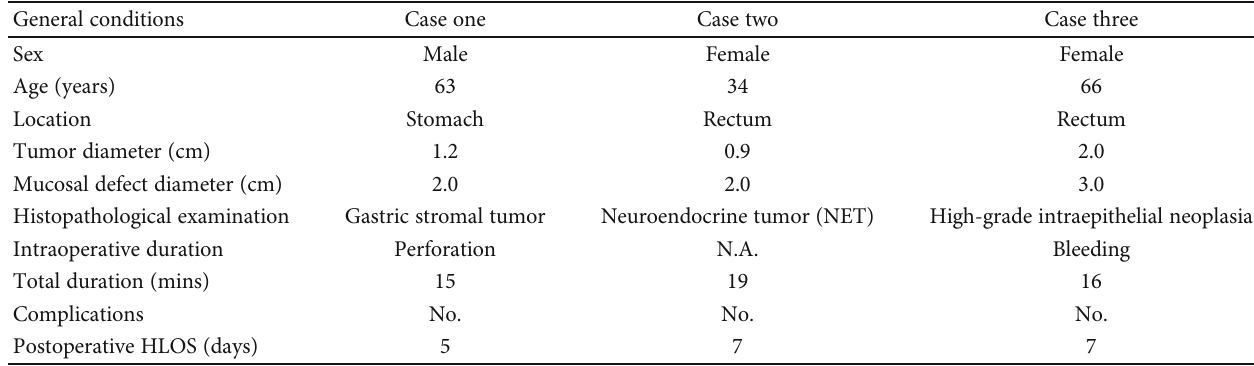
Table 1: General conditions of the patients included in the